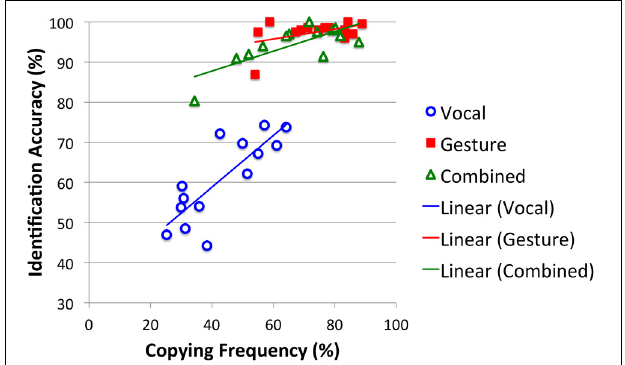
FIGURE 6 | Correlation between Identification Accuracy (mean percent of items correctly identified across games 2–12) and Sign Copying (mean percent of signs copied across games 2–12) for participants in the Vocal, Gesture and Combined